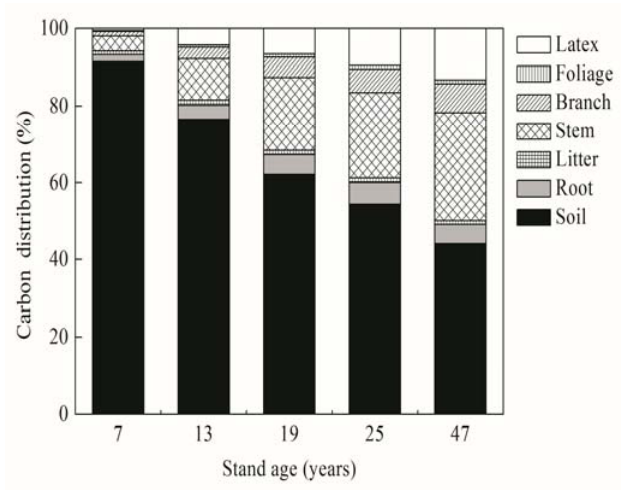
Figure 3. Percentage distribution of carbon stock in various compartments of rubber plantation ecosystem of five different ages. Table 4. The relationship between carbon stored in different compartments of rubber plantation ecosystem and stand age.